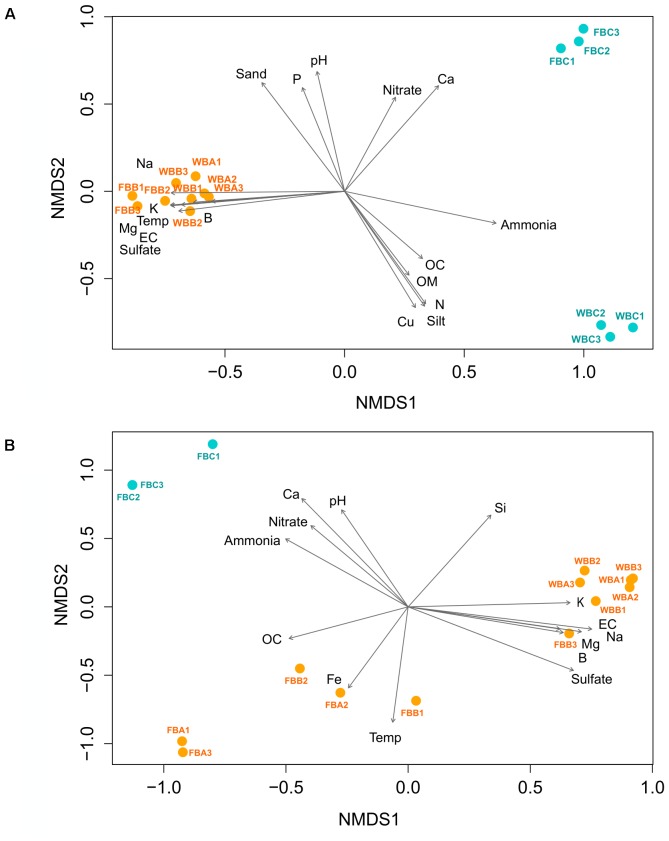
Non-metric multidimensional scaling (nMDS) ordination based on weighted UNIFRAC distance, with plotting of the environmental parameters for bacterial (A) and archaeal (B) communities. Each arrow is significantly correlated to the ordination (envfit, p < 0.05) and represents the direction and strength of the environmental parameter (Temp, temperature; EC, electrical conductivity; OC, organic carbon; OM, organic matter; N, nitrogen). Stress values = 0.007 (A) and 0.01 (B).